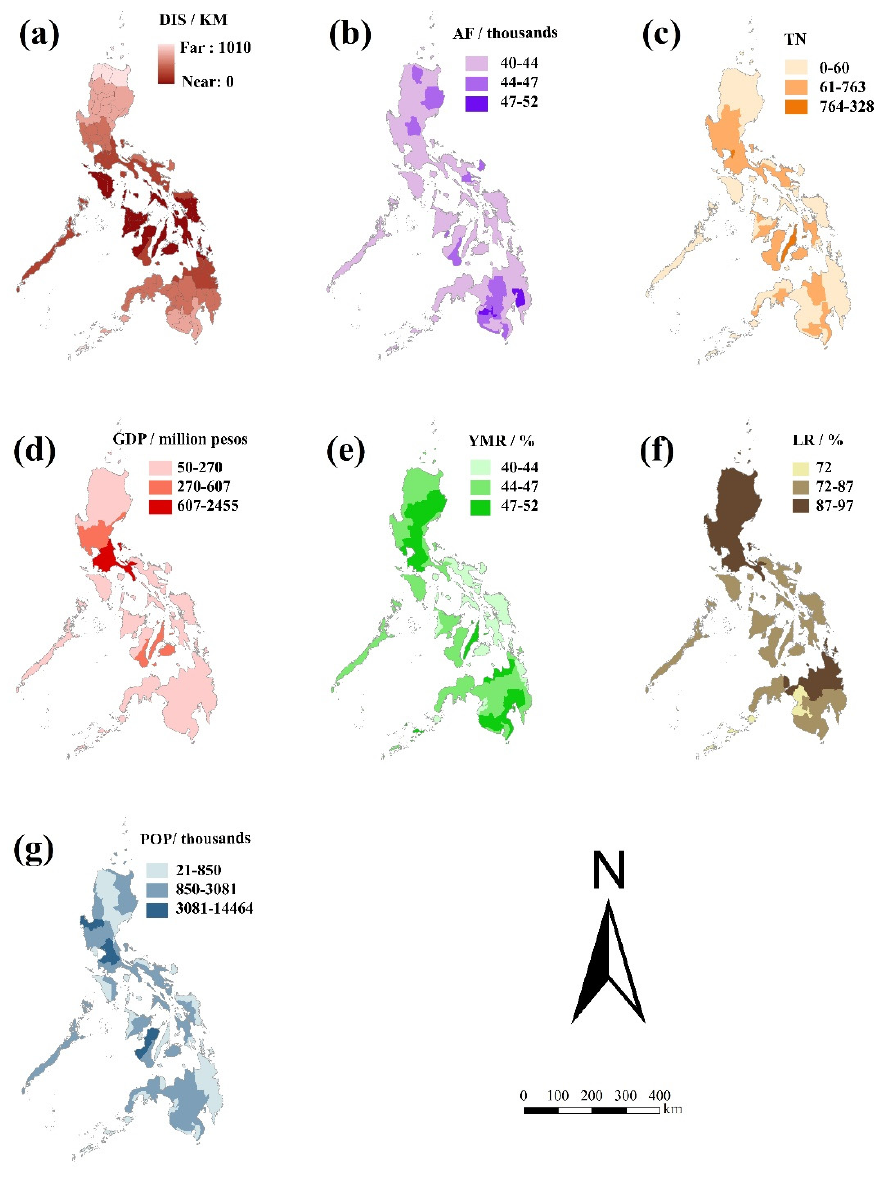
Figure 7. The spatial pattern of 7 specific indicators. ( a )DIS ( b ) AF ( c ) TN ( d ) GDP ( e ) YMR ( f ) LR ( g )POP